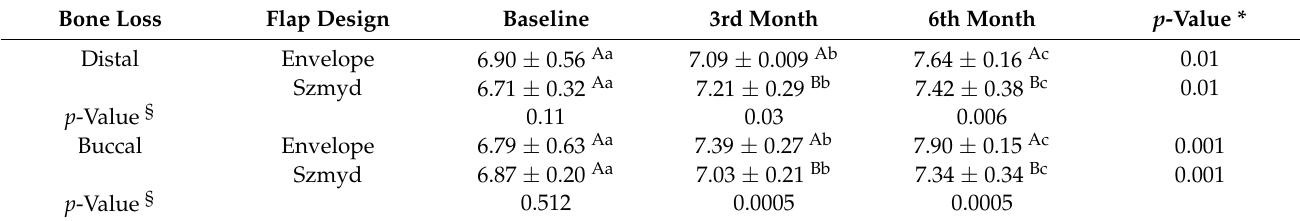
Table 6. Comparison of bone levels (mm) around second molars among study